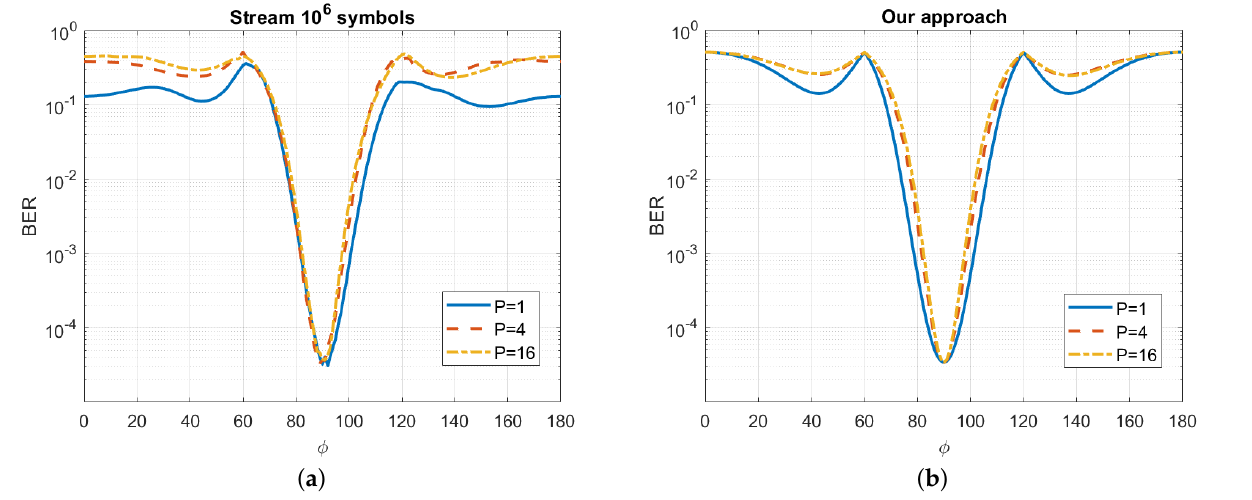
Figure 4. Array of four omnidirectional antennas along x-axis, spacing λ /2. BER in XY plane for DDM and different number of available radiation patterns per symbol ( P ). QPSK modulation, φ 0 = 90 ◦ , SNR( φ 0 ) = 12 dB, PE DDM = 75%. Zero mean artificial Gaussian noise. Only half-plane is plotted due to symmetry. ( a ) Stream of 10 6 symbols. ( b ) Our